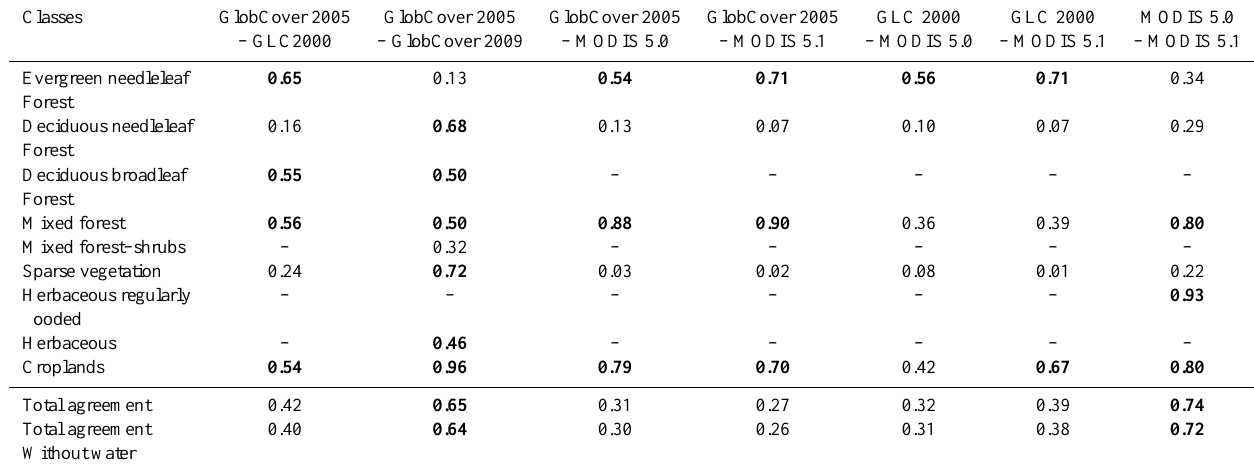
Table 7. Agreement percentages in South Siberia (for the main classes and comparison of Globcover2005 with Globcover2009, GLC2000, MODIS 5.0, MODIS 5.1), values larger than 0.5 appear in